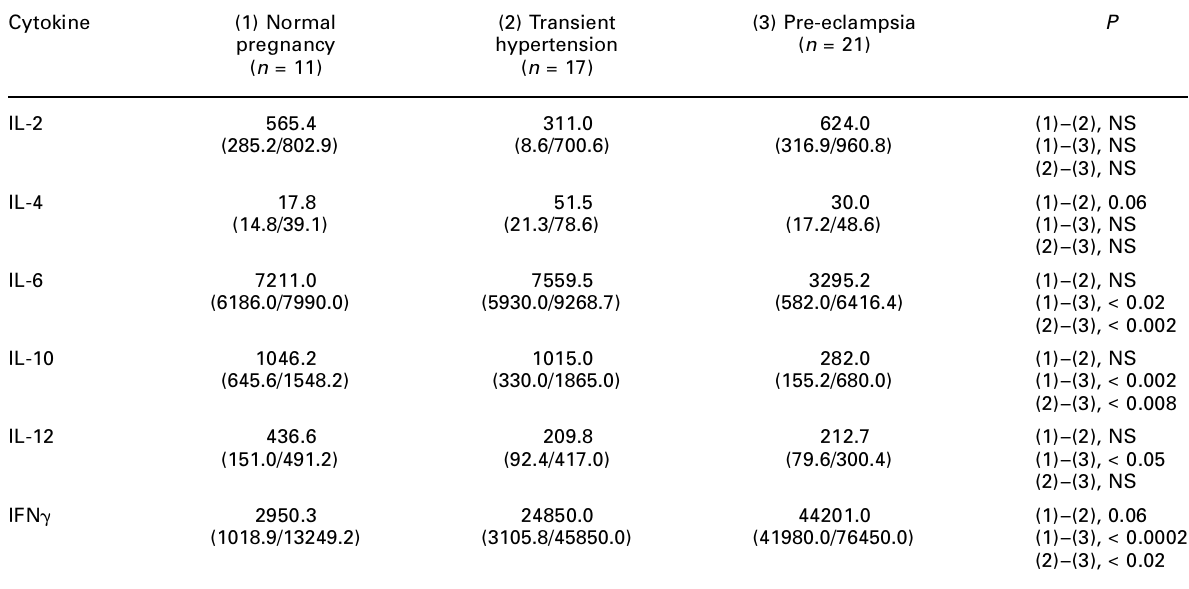
Table 4. PHA-stimulated cytokine secretion (pg/ml) from cultured decidual lymphocytes of normal pregnant women, and pregnant patients with transient hypertension and pre-eclampsia